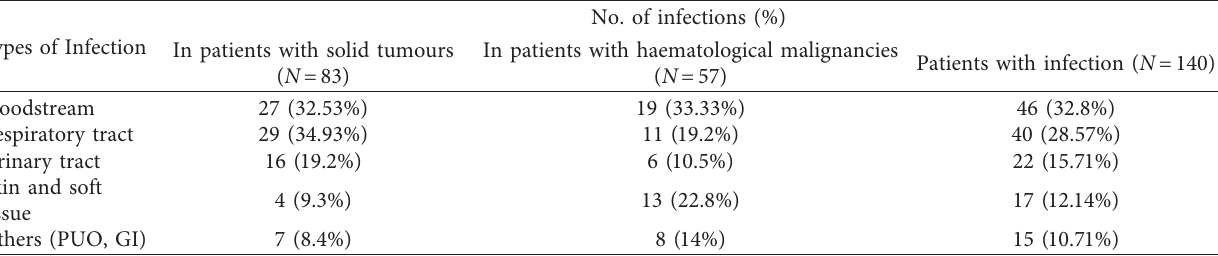
Table 1: Types of infection in patients with solid tumors and haematological malignancies.